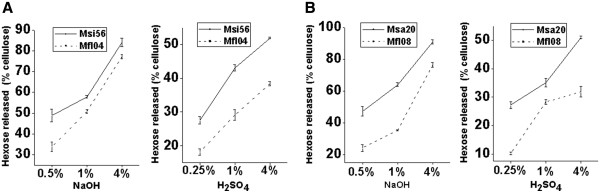
Hemicelluloses dominant effects on biomass saccharification. Increase of hemicelluloses level in (A) cellulose-high sample (Msi56) or (B) lignin-rich sample (Msa20) resulting in a raised biomass digestibility after pretreatments with NaOH or H2SO4 at three concentrations.